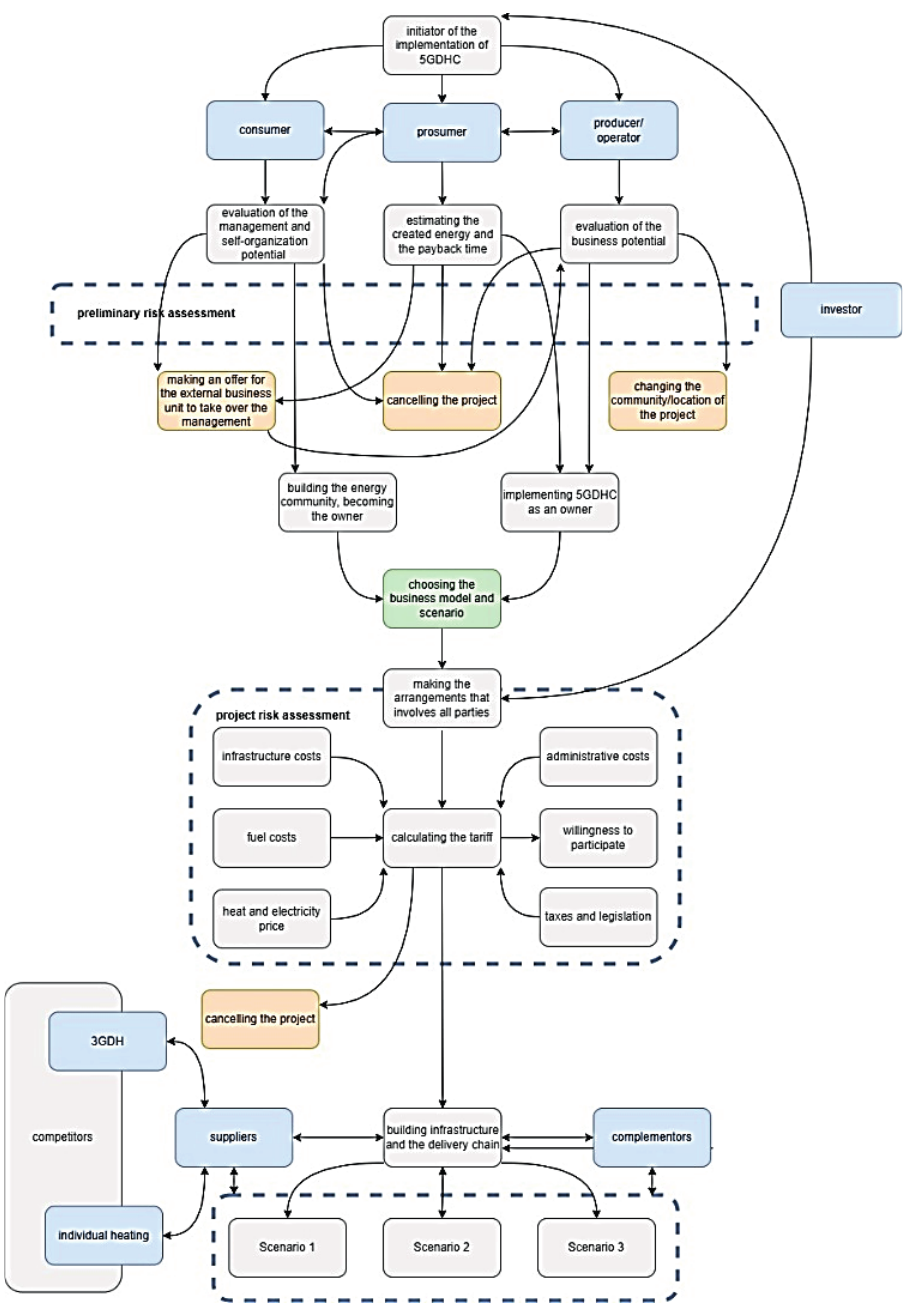
Fig. A1. Main steps to identify the most beneficial business model